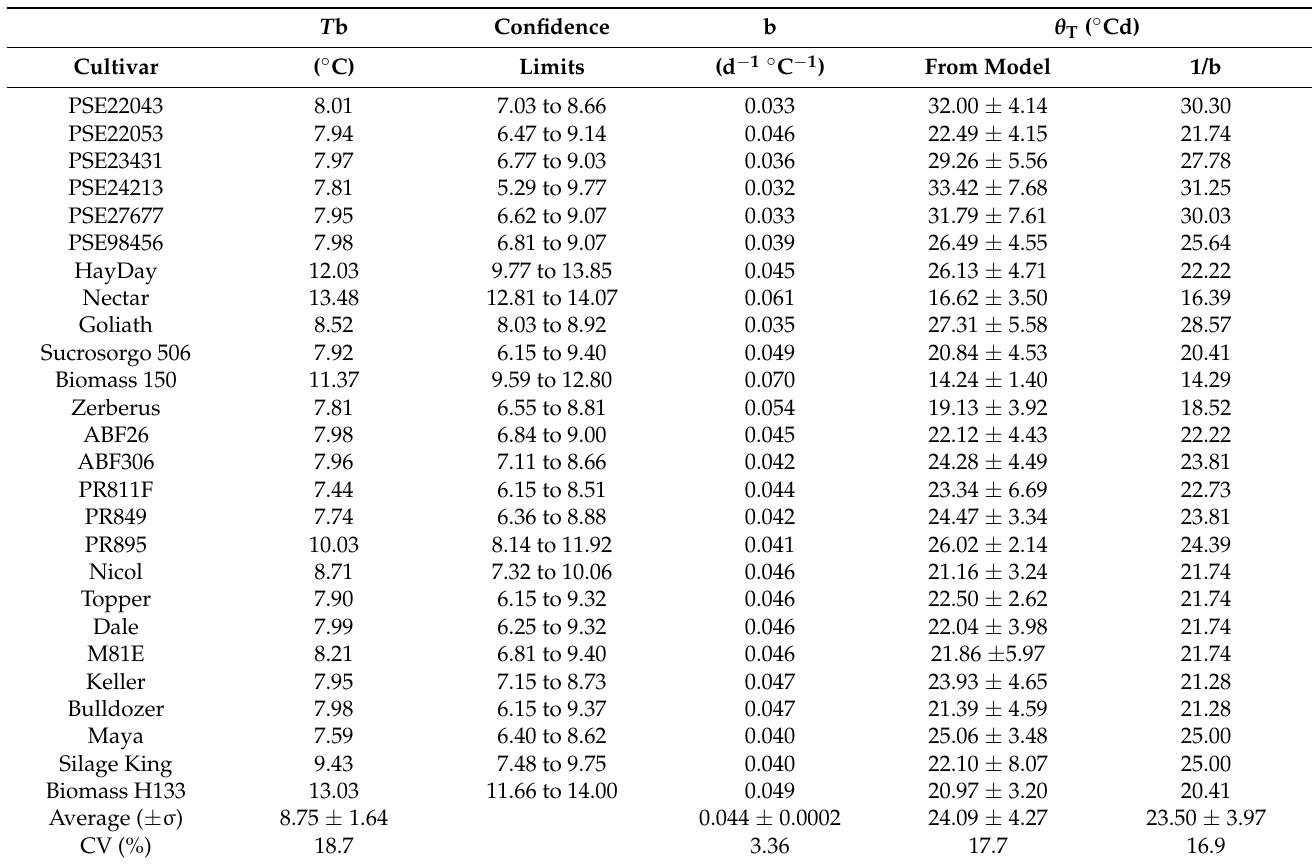
the two parameters (Tb and θ T ) corresponded to ‘Zerberus’, ‘Sucrosorgo 506’, ‘Jumbo’ and ‘PR811F’ (all in quadrant A). Contrastingly, in the upper right side of the figure (quadrant C), the worst combination corresponded to cultivars ‘HayDay’ and